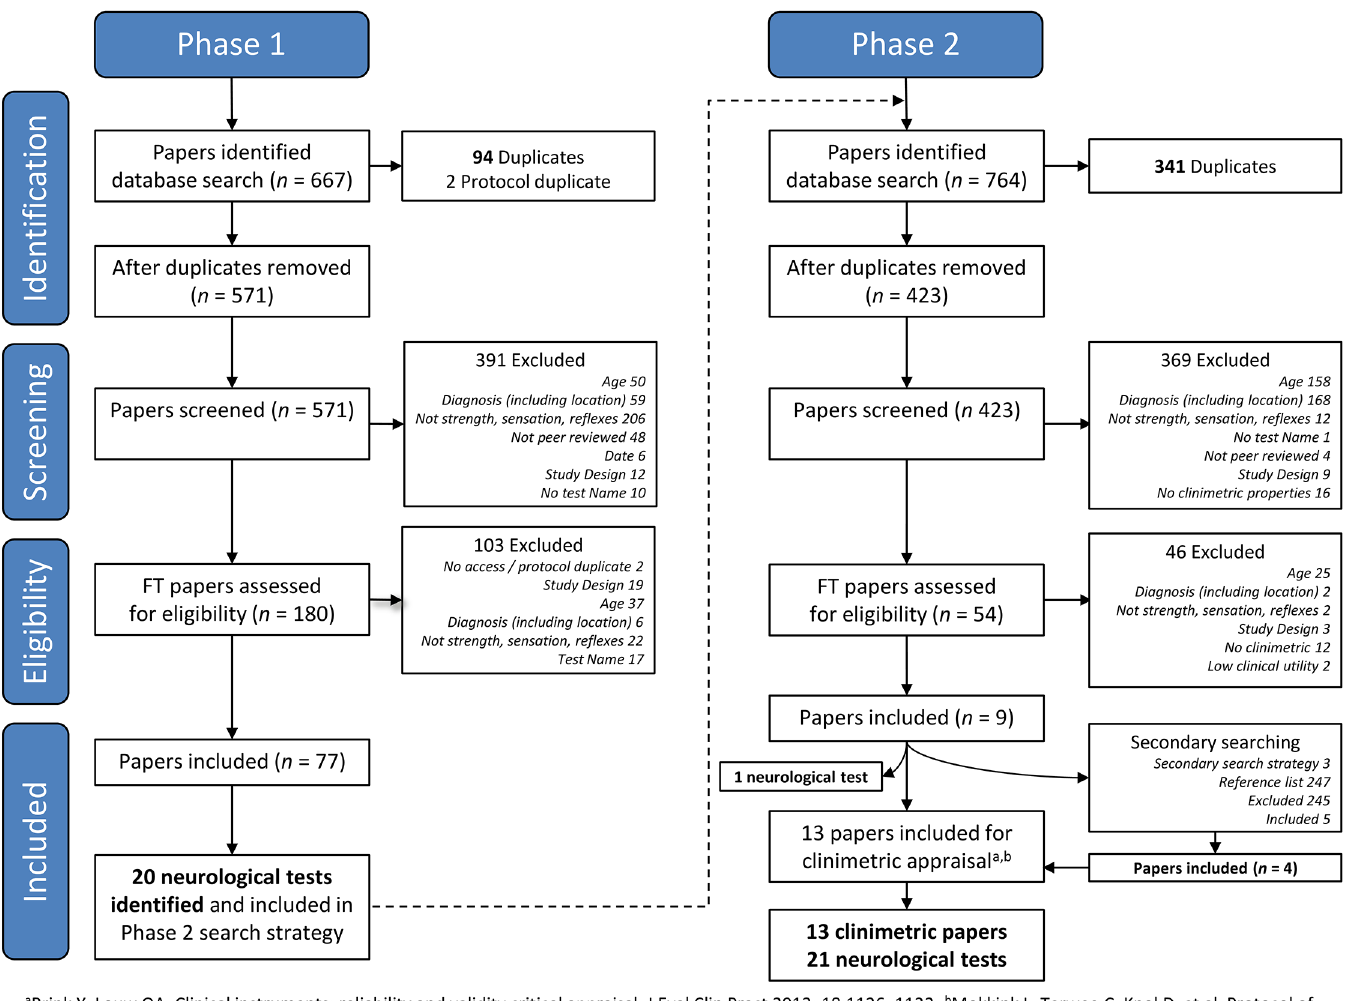
Fig 1. PRISMA flow diagram of systematic search strategyused to identify clinimetric